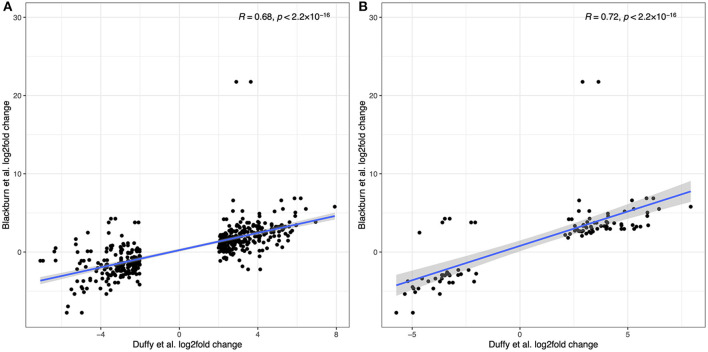
Comparison of differentially expressed genes reported in Duffy et al. to the current study. (A) log2fold correlations between 449 overlapping transcripts between the two studies. (B) log2fold correlations for the subset of overlapping transcripts that were differentially expressed in both studies.